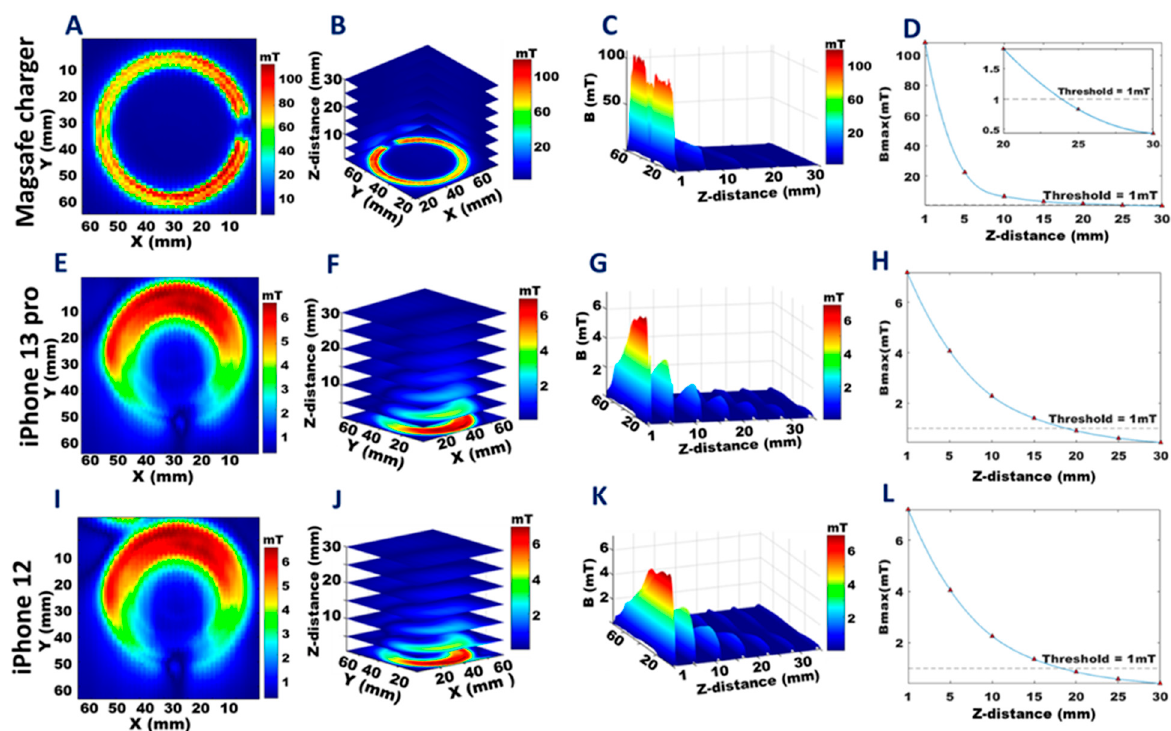
Figure 7. Distribution of the stray magnetic fields of the MagSafe charger, the MagSafe charger + iPhone 13 Pro, and the MagSafe charger + iPhone 12. The colors represent the strength of the magnetic fields and are scaled to the maximum B-field obtained for each dataset. A , E , and I : The 2D distribution of the stray magnetic field obtained for a transversal plane placed at a z-distance of 1 mm from the front plane of the standalone MagSafe charger ( A ), from the MagSafe charger + iPhone 13 Pro ( E ), and the MagSafe charger + iPhone 12 ( I ). B , F , and J : The 3D distribution of the stray magnetic field for transversal planes placed at z = 1, 5, 10, 15, 20, 25, and 30 mm from the front of the standalone MagSafe charger ( B ), from the MagSafe charger + iPhone 13 Pro ( F ), and the MagSafe charger + iPhone 12 ( J ). C , G , and K : The 3D stray magnetic field (B) variation with increasing z-distance from the front plane of the standalone MagSafe charger ( C ), the MagSafe charger + iPhone 13 Pro ( G ), and the MagSafe charger + iPhone 12 ( K ). D , H , and L : Maximum stray magnetic field (B max ) versus the z-distance from the front plane of the standalone MagSafe charger ( D ), of the MagSafe charger + iPhone 13 Pro ( H ), and the MagSafe charger + iPhone 12 ( L ).